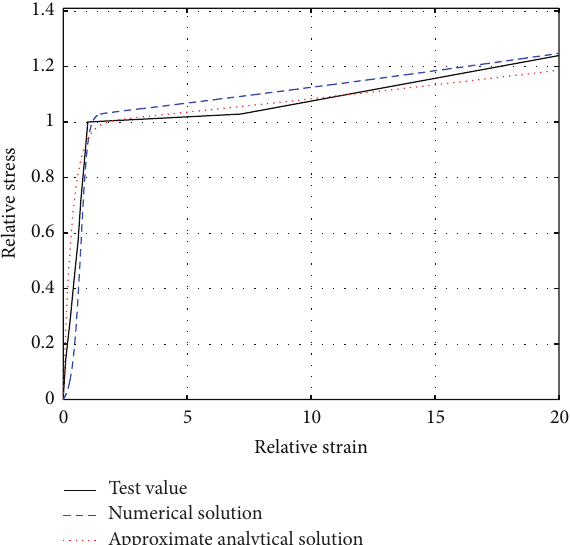
Figure 5: Steel constitutive curves for different results.